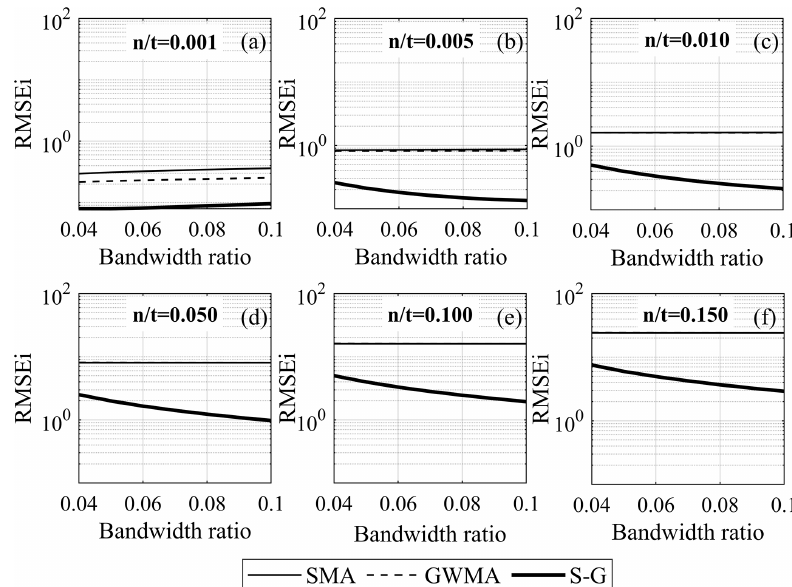
Figure 12. RMSEi for the harmonic scenarios on a semi-logarithmic scale.